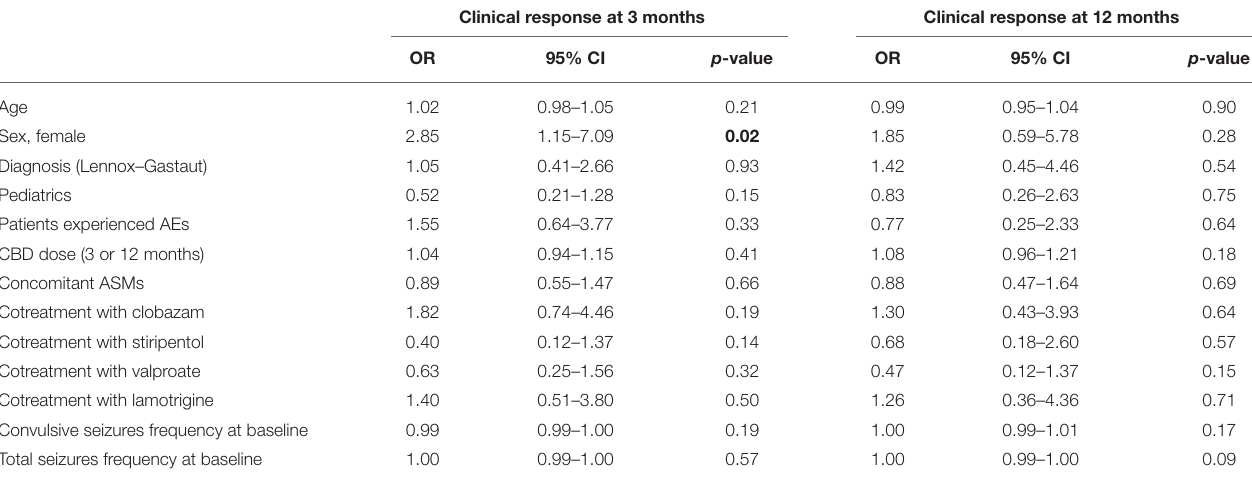
TABLE 4 | Univariate regressions with selected variables for clinical response.